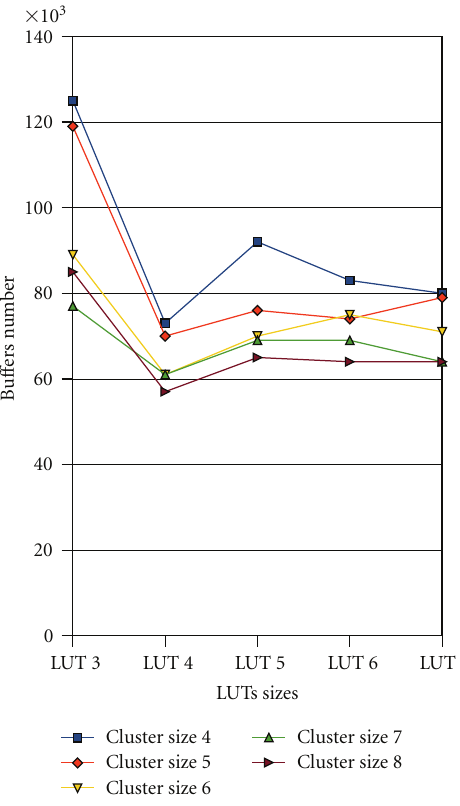
Figure 10: Critical path switches number clusters sizes 4–8 (21 benchmark average).